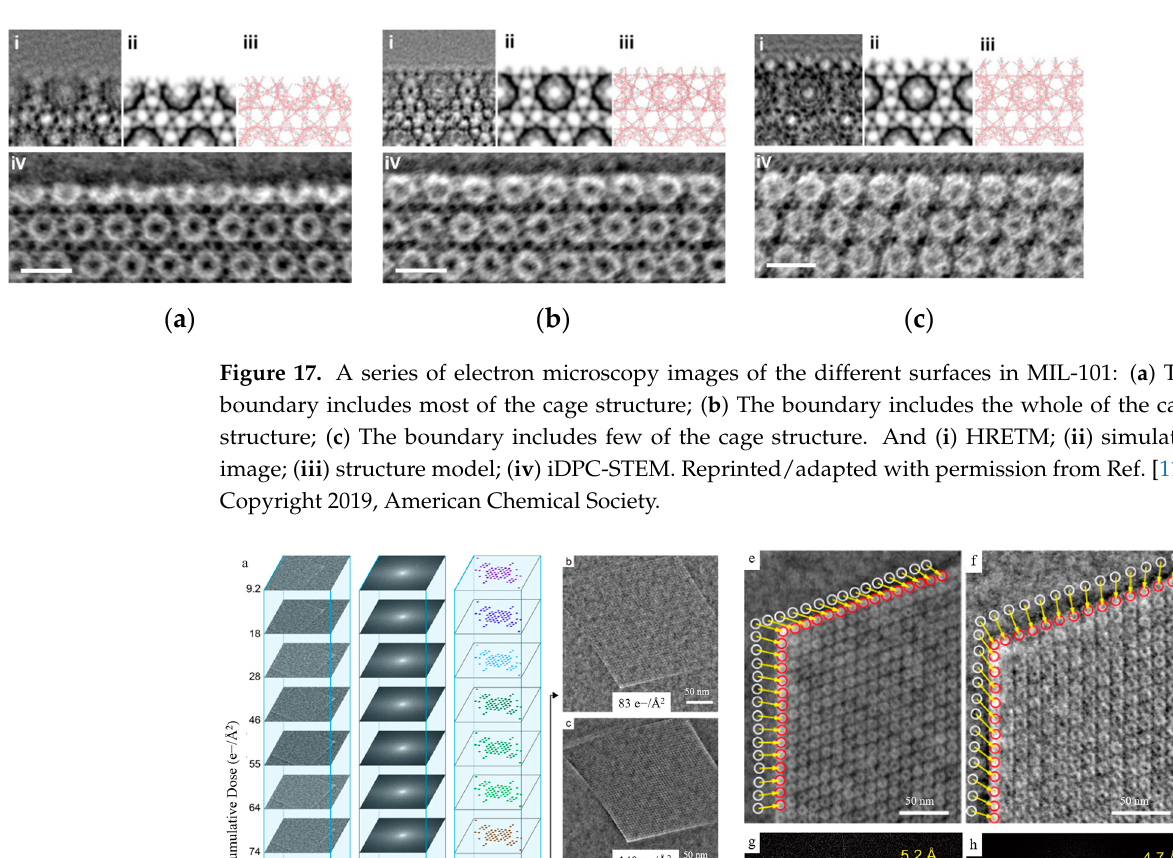
Figure 16. A series of electron microscopy images of MIL-101 acquired in different years: ( a ) HRTEM image in 2005. Reprinted/adapted with permission from Ref. [112]. Copyright 2005, American